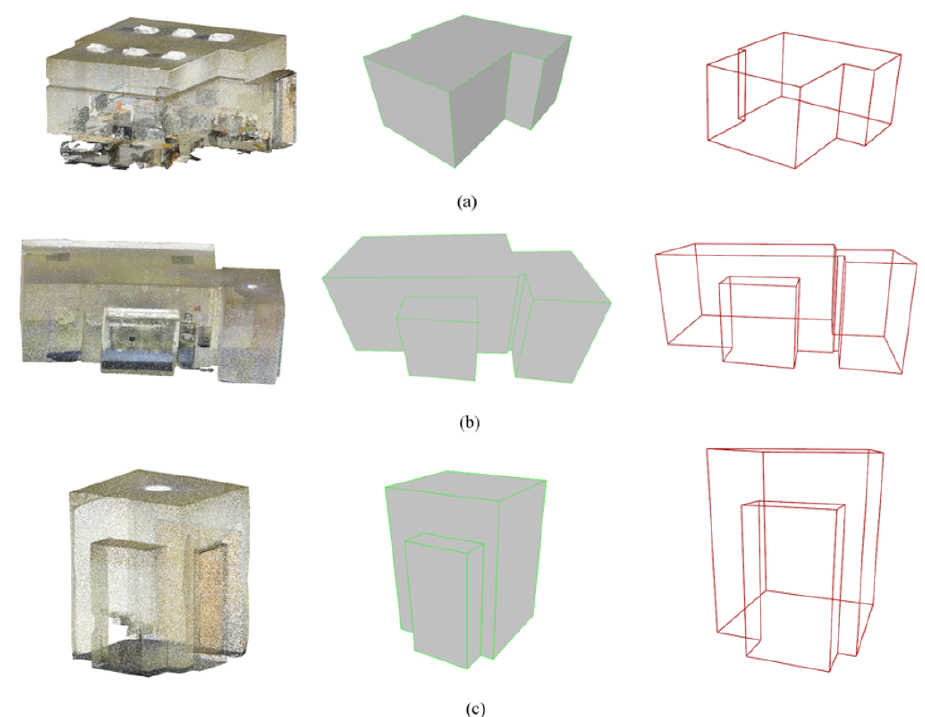
Figure 7. Zoom-in view of irregular shape indoor environment in Area 1/2D-3D-S: ( a ) Office 16, which is irregular in shape; ( b ) WC 1, which has an uneven ceiling height; and ( c ) the small structural in Hallway 1.